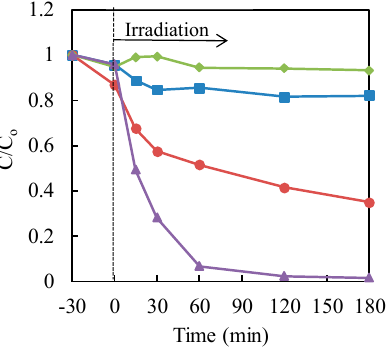
Figure 4. E ff ect of the hole scavengers on the photocatalytic reduction of Cr(VI) in aqueous solution with P25 TiO 2 . Cr(VI) sample: 30 µ g · mL − 1 (30 mL); TiO 2 : 20 mg (0.67 mg · mL − 1 ). Triangle (purple): TiO 2 with formic acid (3000 µ g · mL − 1 ); circle (red): TiO 2 with ammonium formate (3000 µ g · mL − 1 ); square (blue): formic acid (3000 µ g · mL − 1 ) only; diamond (green): ammonium formate (3000 µ g · mL − 1 ) only.